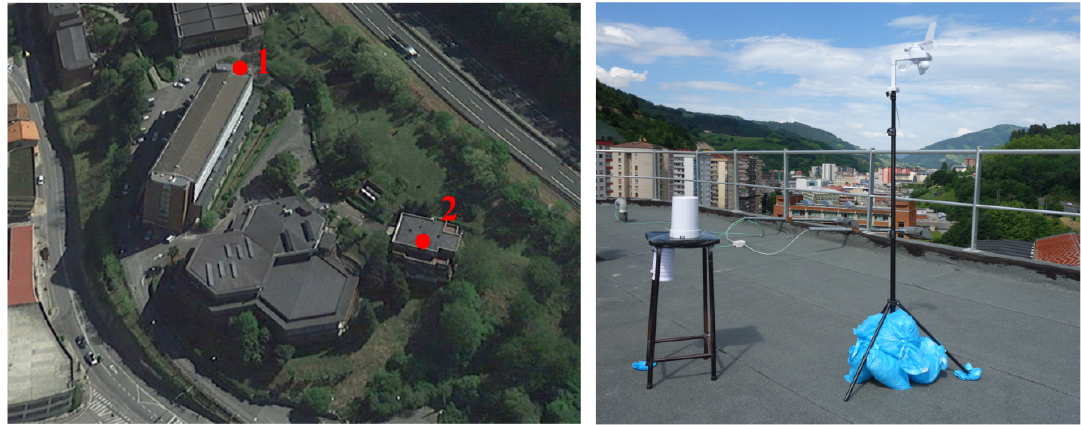
Figure 1. Selected buildings and anemometers 1 and 2 on the